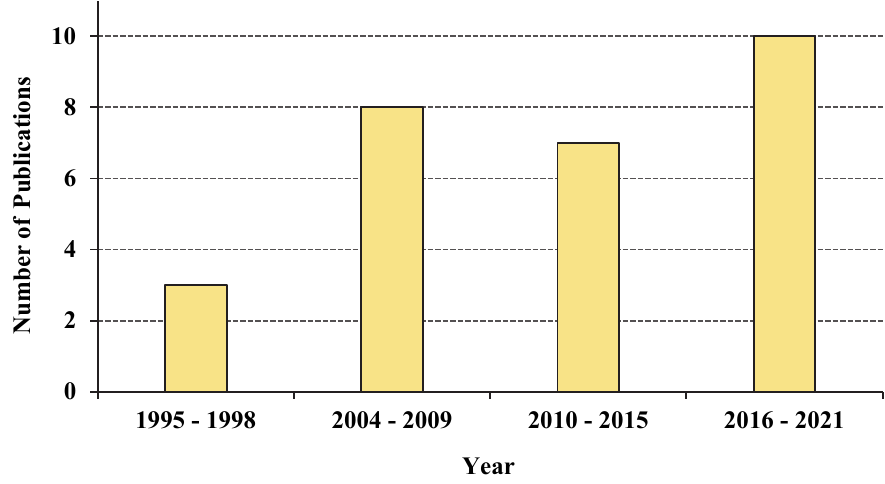
Figure 5: Number of publications in the field of SHM.